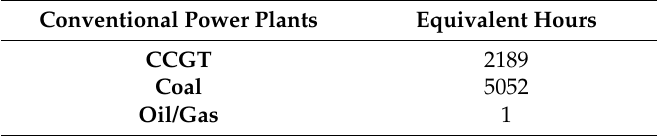
Table 6. Equivalent hours of conventional power plants, resulting from the